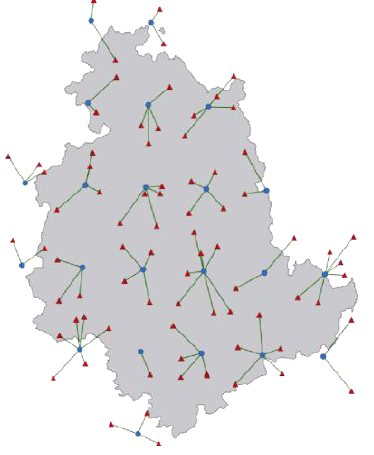
Figure 3. Minimum distance criteria used to couple, each TMPA centroid (blue circles) with one or more VRF rain gauge stations (red triangles). The example refers to the coupling in the Umbria region (Central Italy).